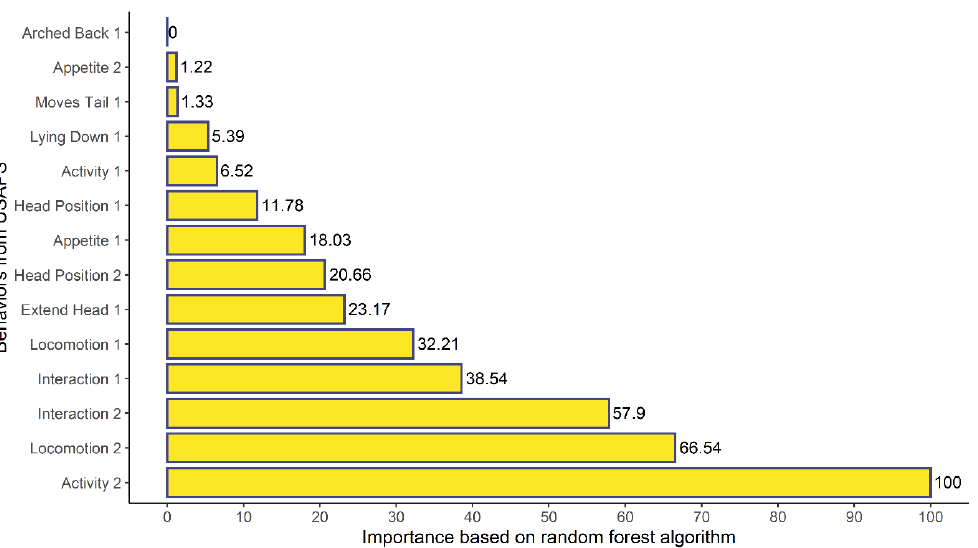
Figure 2. Importance of each behavior from USAPS based on the random forest algorithm using the expert opinion (no event = no indication of analgesia; event = indication of analgesia) as the predictor variable.